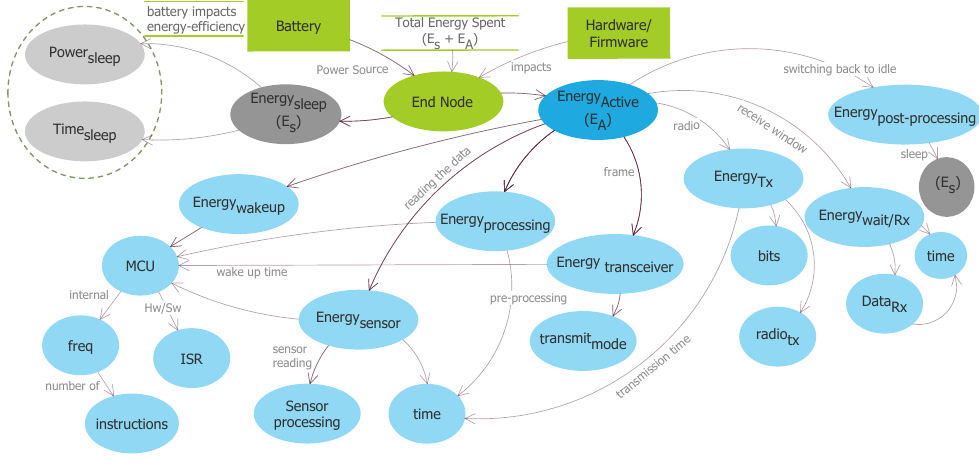
Figure 3. Generic representation for different states of energy consumption in an LPWAN